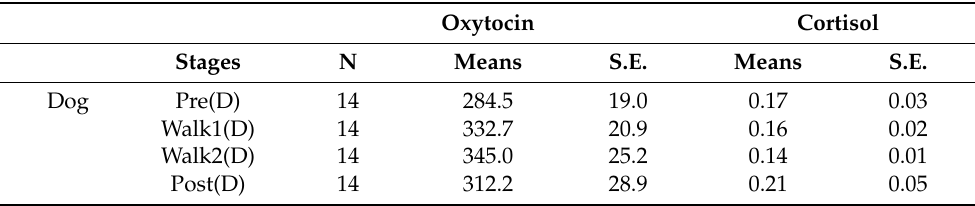
Table 4. Oxytocin and cortisol concentrations in dog’s saliva, Experiment II. Oxytocin Cortisol Stages N Means S.E.